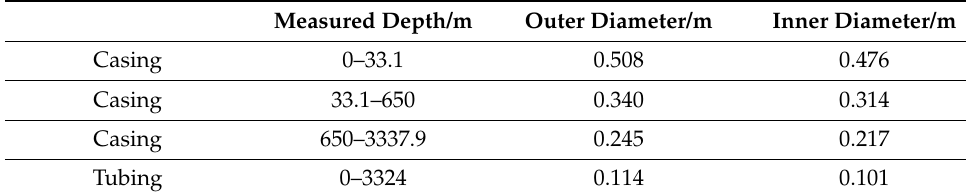
Table 2. Tubing, casing dimensions, and running depths.